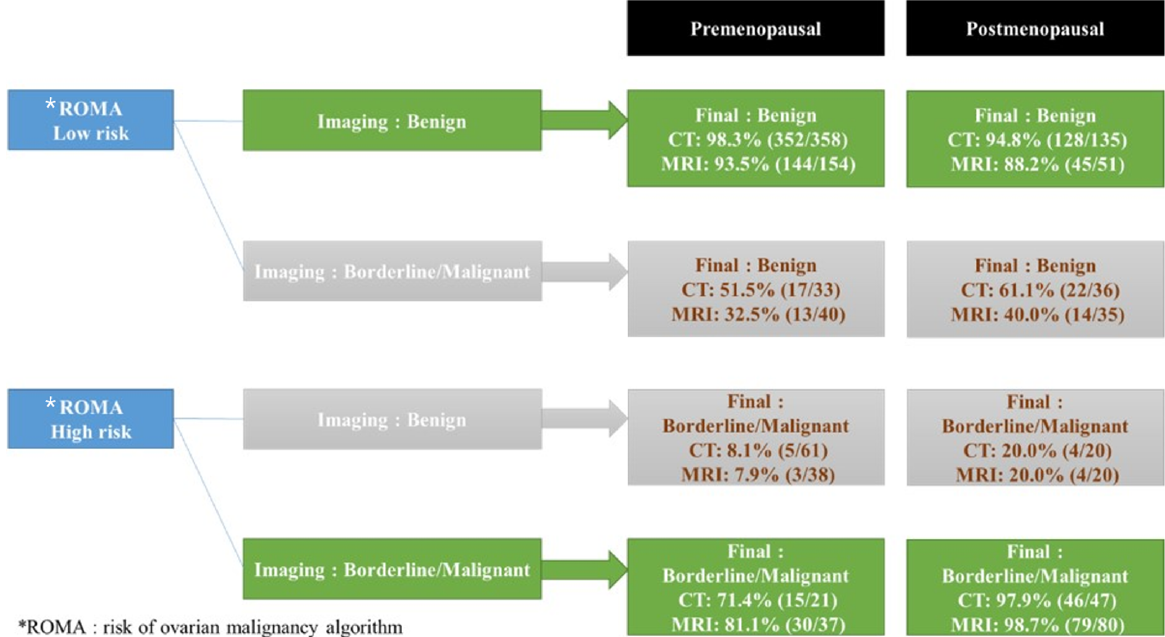
Figure 1. Predictive values of final diagnosis in ROMA, CT, and MRI in cases consistent with the ROMA and imaging and cases with discrepancies between ROMA and CT or MRI. Nine patients in the CT group and ten patients in the MRI group were excluded from this analysis due to inconclusive CT or MRI interpretations shown in Table 2. * ROMA: risk of ovarian malignancy